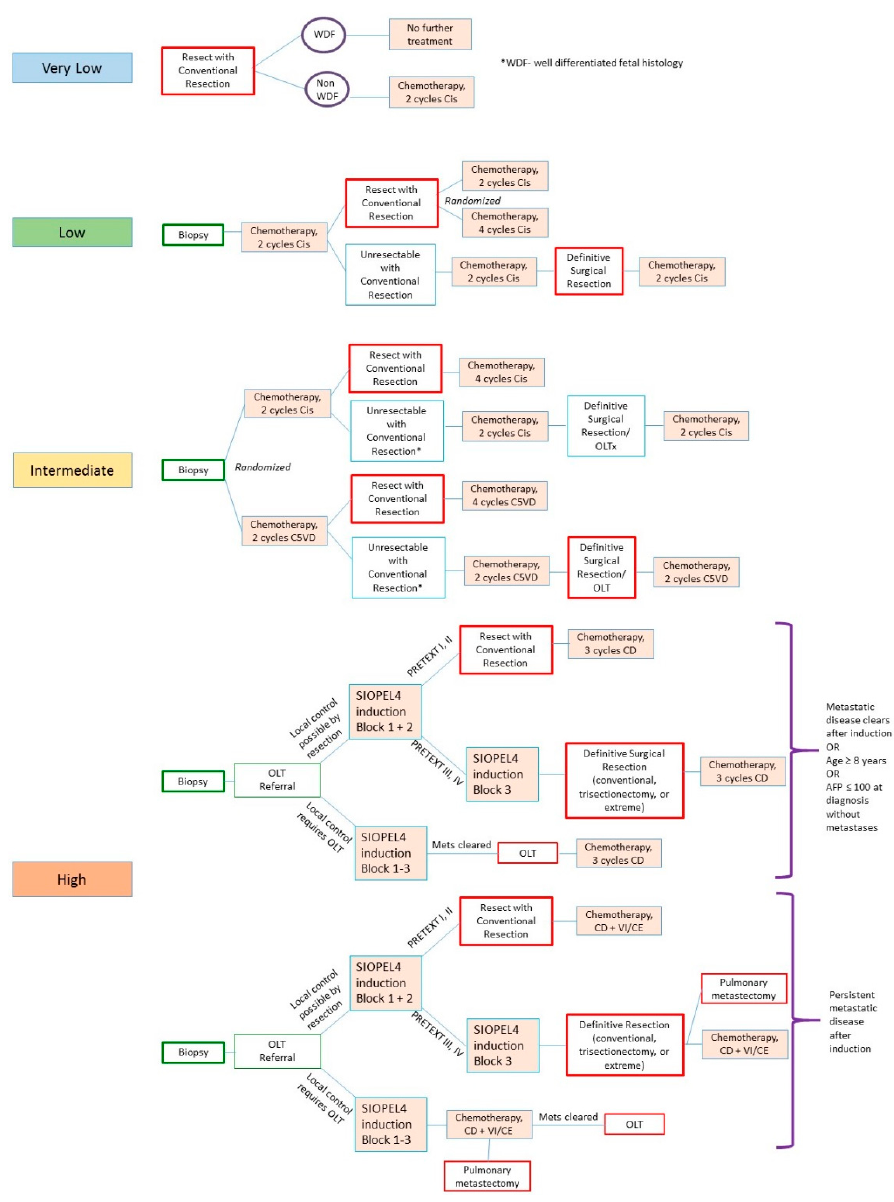
Figure 3. Treatment strategy under AHEP-1531. Management varies based on risk (very low to high) and PRETEXT stage. Cis = cisplatin; C5VD = cisplatin, 5-fluorouracil, vincristine, doxorubicin; CD = carboplatin, doxorubicin; VI/CE = vincristine, irinotecan, or carboplatin, etoposide; WDF = well-differentiated fetal; SIOPEL = Soci é t é Internationale d’Oncologie P é